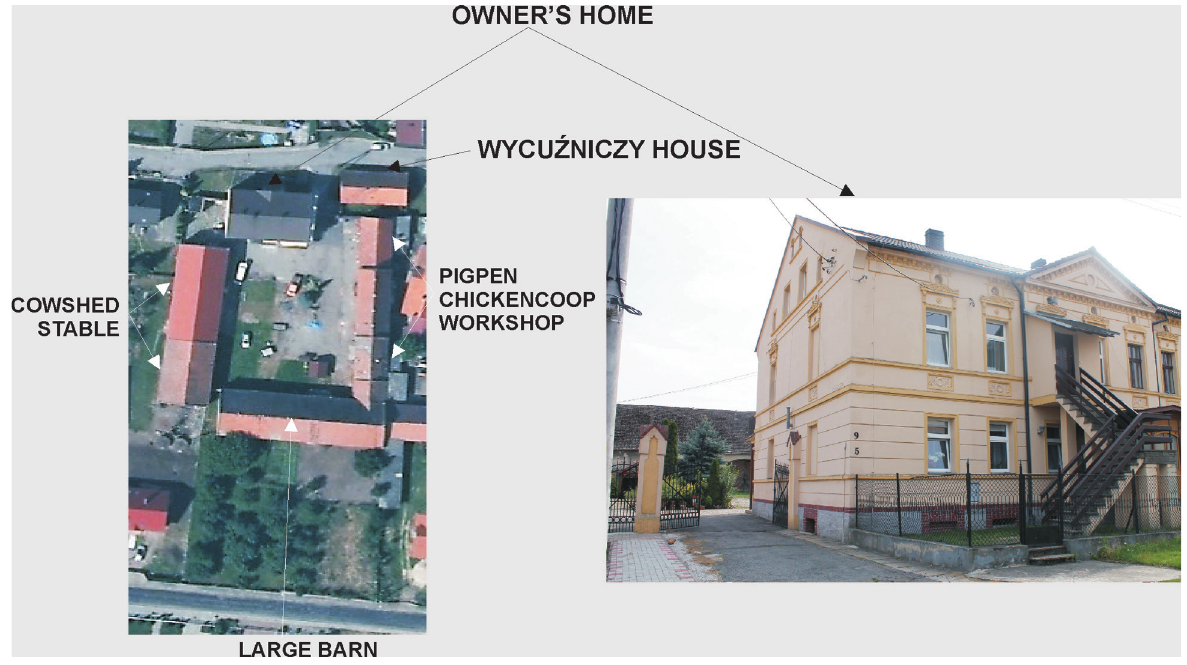
Fig. 3. The spatial and functional layout of a Franconian homestead in Borek Strzeliński in Św. Floriana St. Source: J.